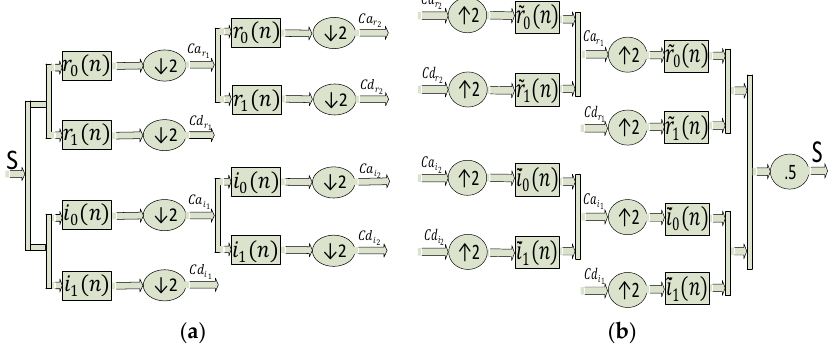
Figure 1. The two-level filter bank implementation of ( a ) DTCWT and ( b ) IDTCWT.